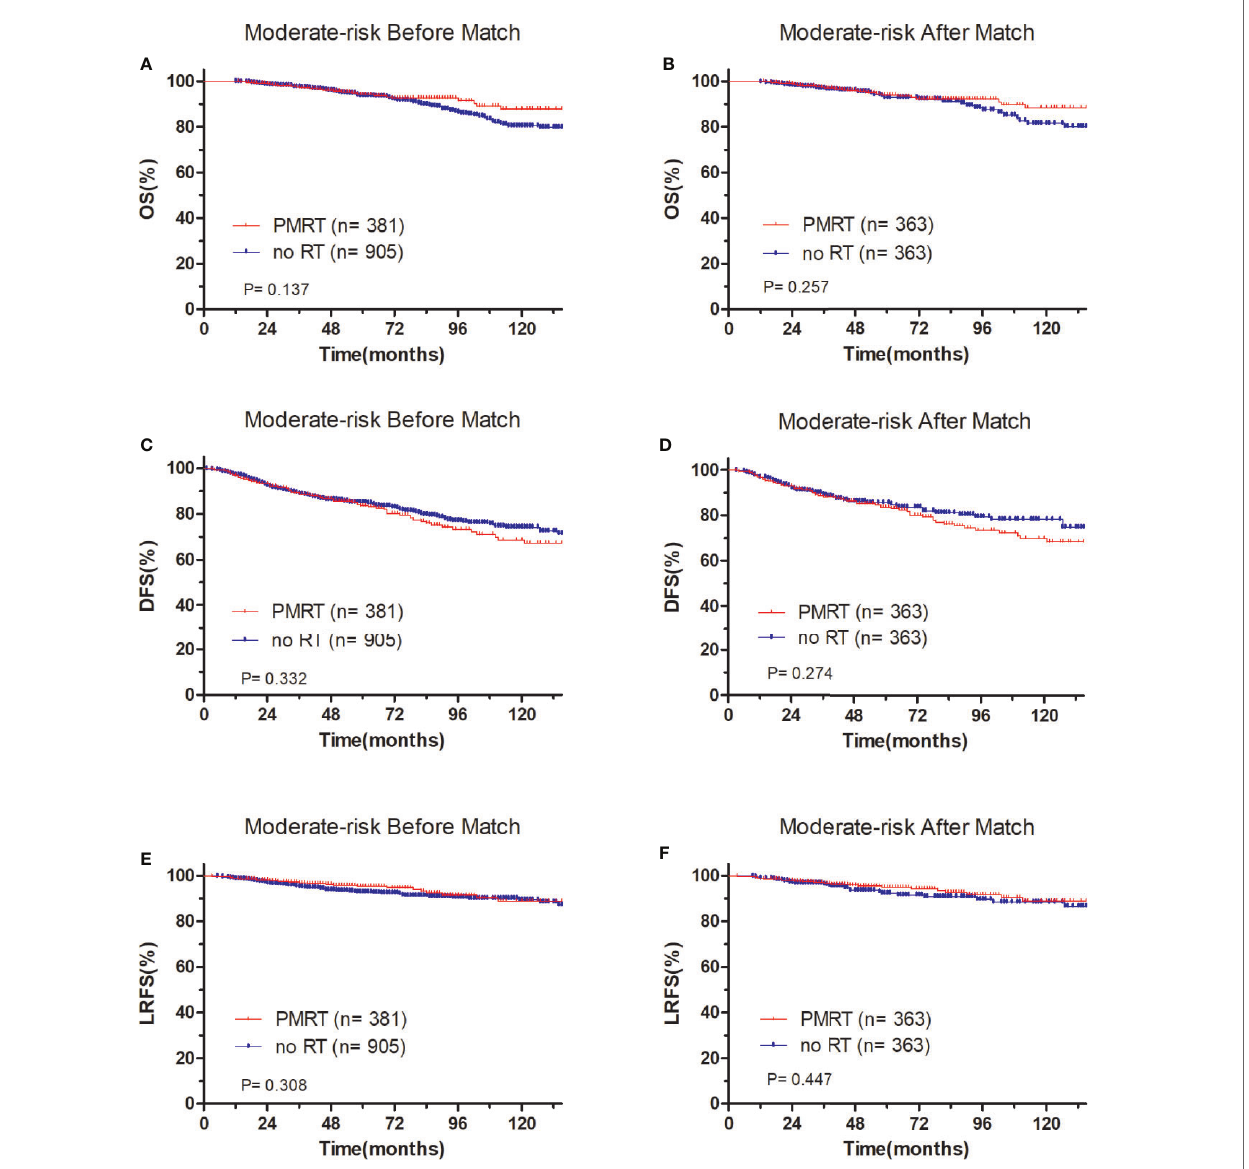
FIGURE 5 | Comparison of OS and DFS and LRFS between with PMRT and without PMRT for moderate-risk pT1-2N1M0 patients. For patients with PMRT or without PMRT, OS before (A) and after (B) match strati fi cation; DFS before (C) and after (D) match strati fi cation; LRFS before (E) and after (F) match strati fi